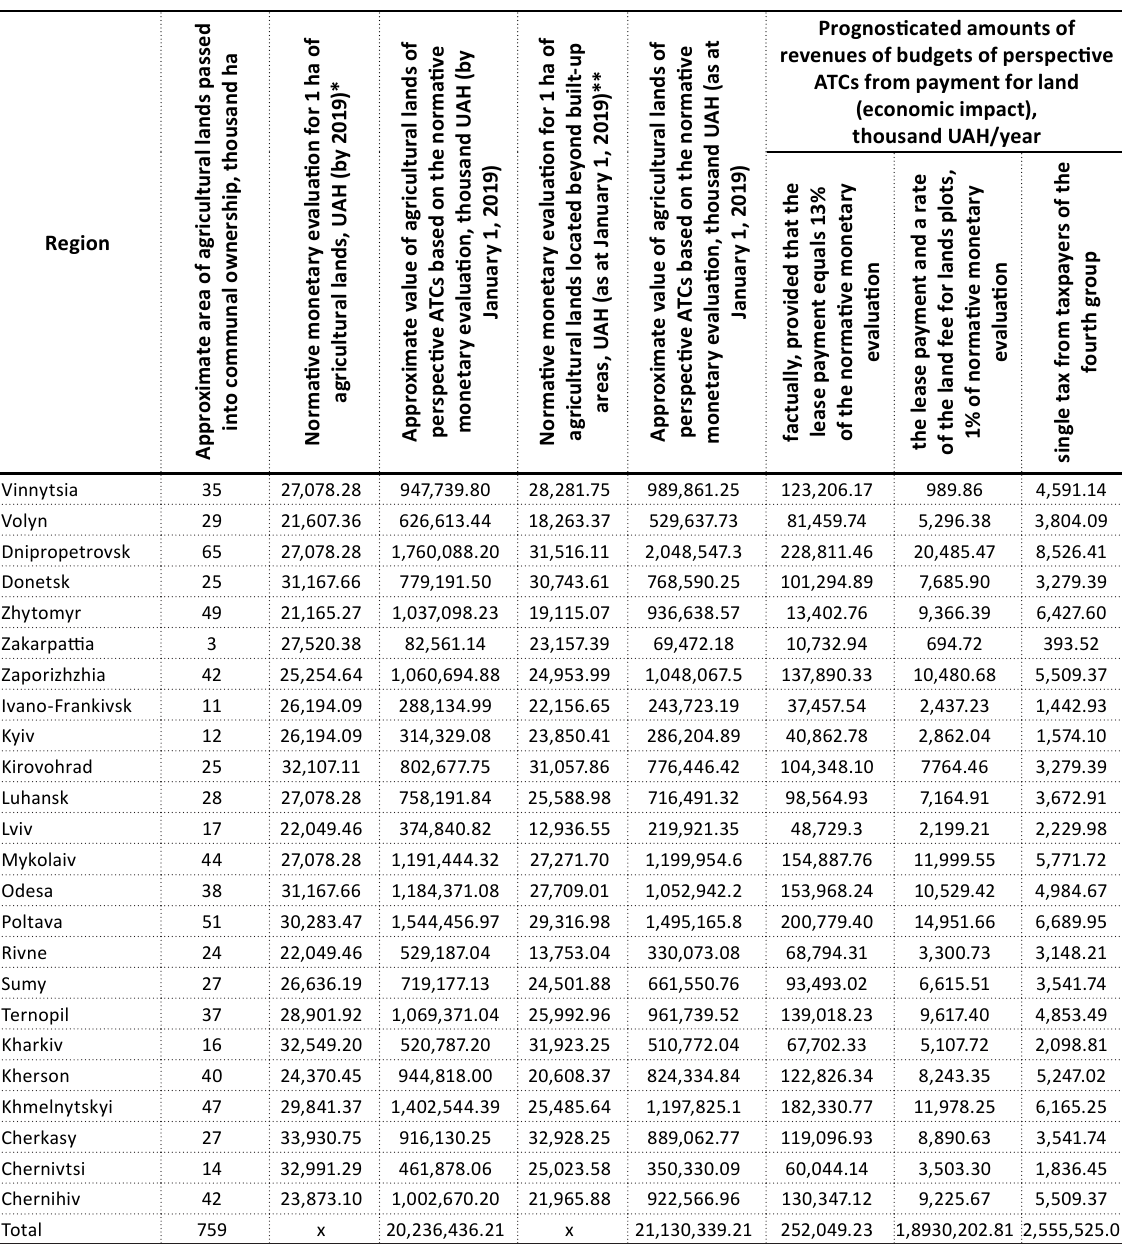
Table 3. Economic efficiency of the use of land plots located beyond built-up areas in terms of passing them into ownership of united territorial